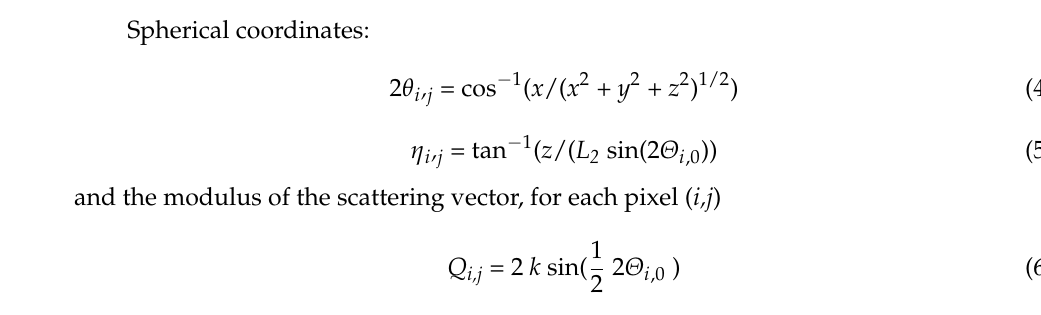
Figure 5. Neutron diffractograms integrated over all orientations for incident wavenumbers k 1 = 4.08 Å − 1 and k 2 = 2.61 Å − 1 , together with time-of-flight data acquired data at TAKUMI for comparison of instrumental resolution. The intensity scale